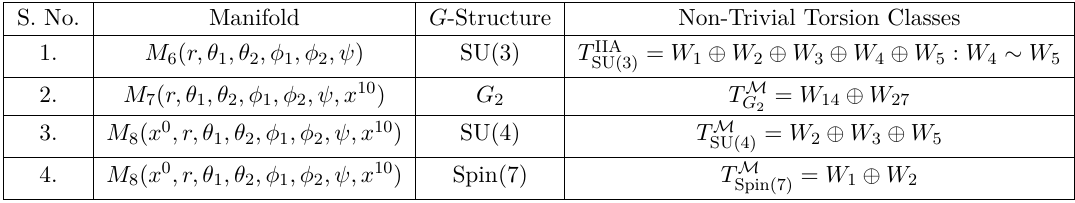
Table 2 . Summary of IR G -Structure Torsion Classes of Six-/Seven-/Eight-Folds in the type IIA/ M -Theory Duals of Thermal